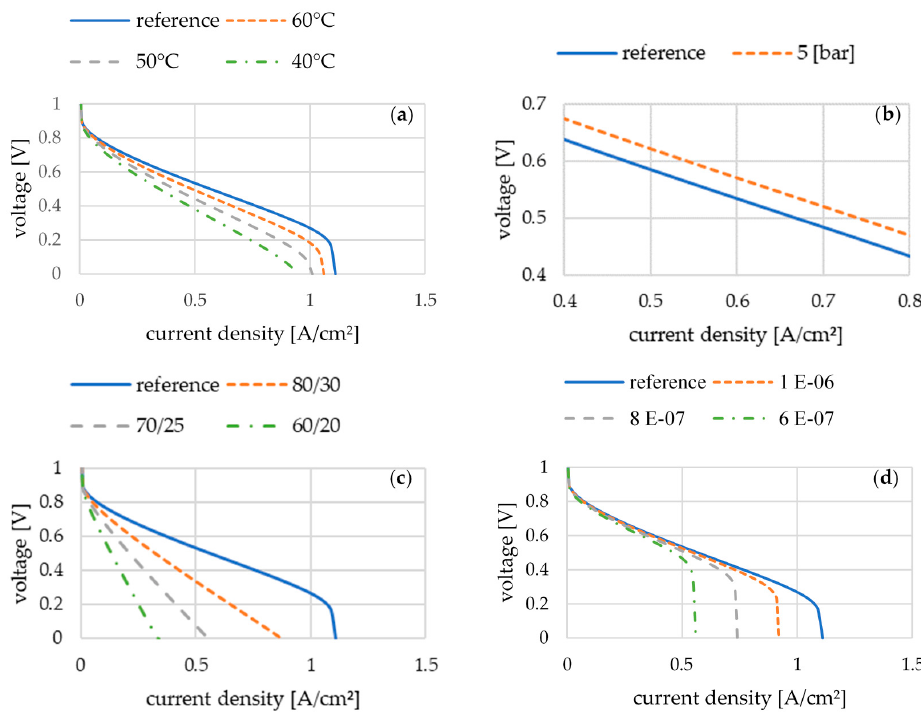
Figure 4. Simulation results for variations of ( a ) temperature; ( b ) pressure; ( c ) RH [%]; ( d ) O2 concentration [mol/cm 3 ].